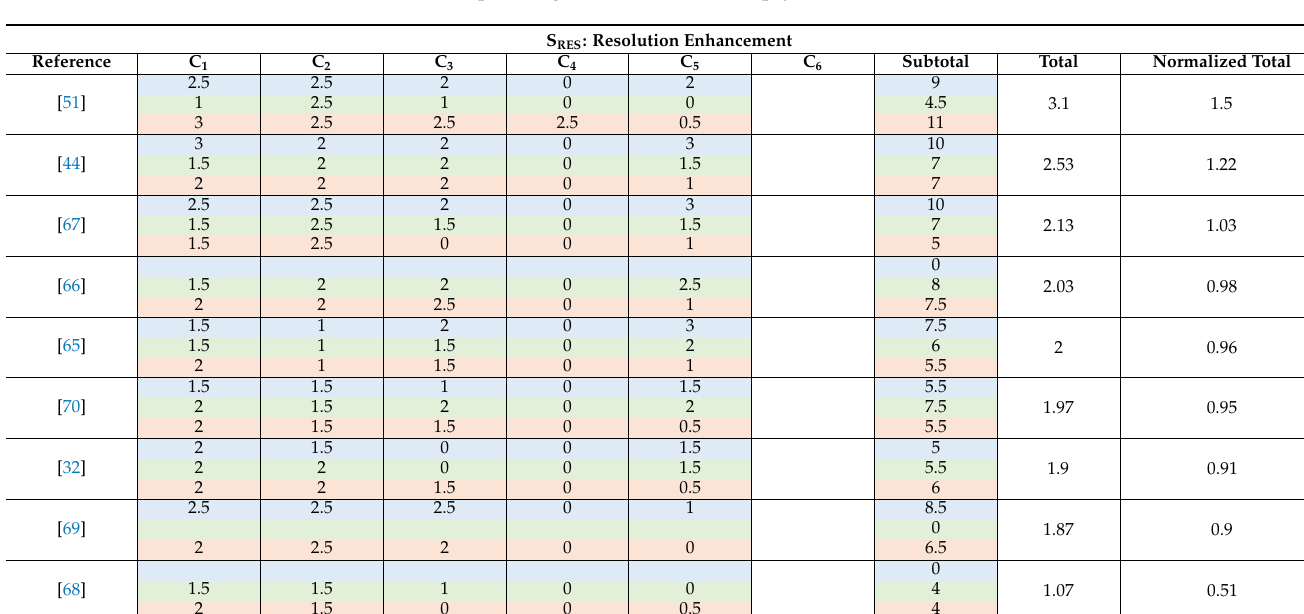
Table A2. Analytical ratings for all studies included in S RES . The color in the table rows indicates the category of experiments as follows: numerical experiments , experiments with phantoms , and experiments with humans in vivo . The evaluation criterion C 6 was not applicable to this subgroup, thus the corresponding column was left